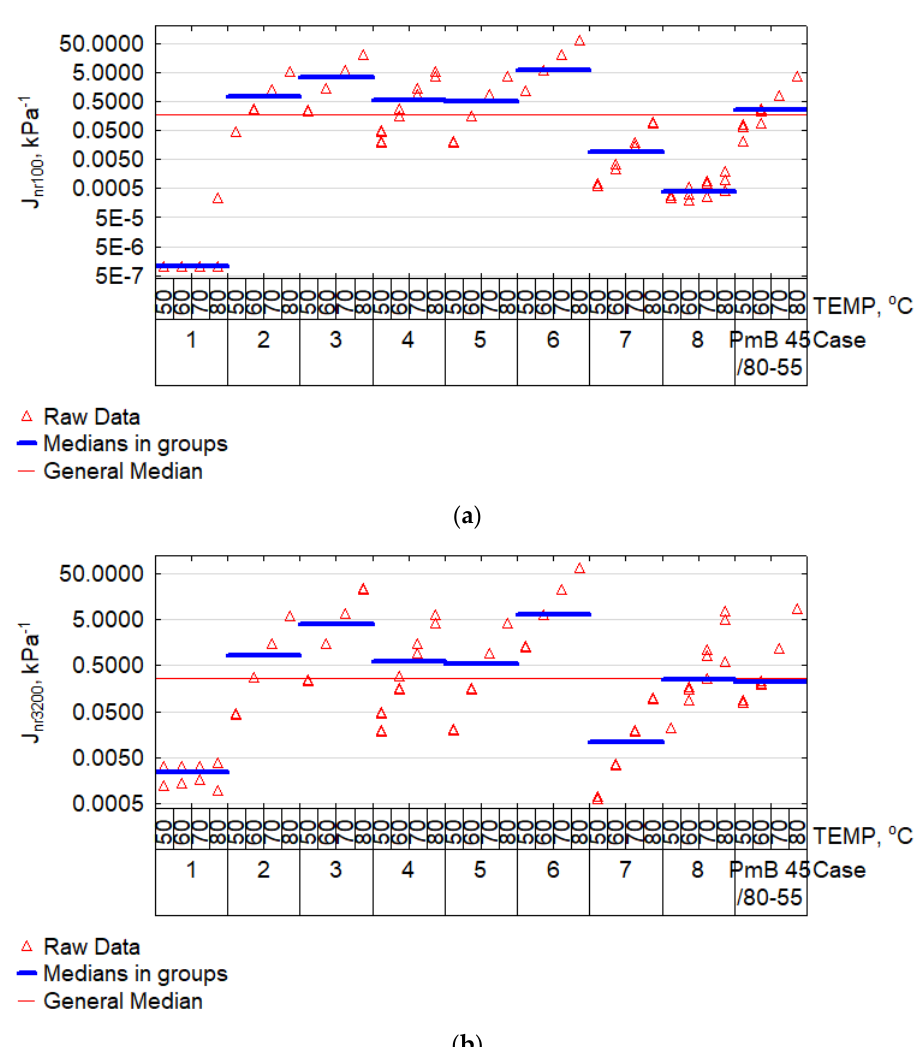
Figure 8. Plot of creep compliance Jnr for shear stress: ( a ) 100 Pa (Jnr 100 ); ( b ) 3200 Pa (Jnr 3200 ).